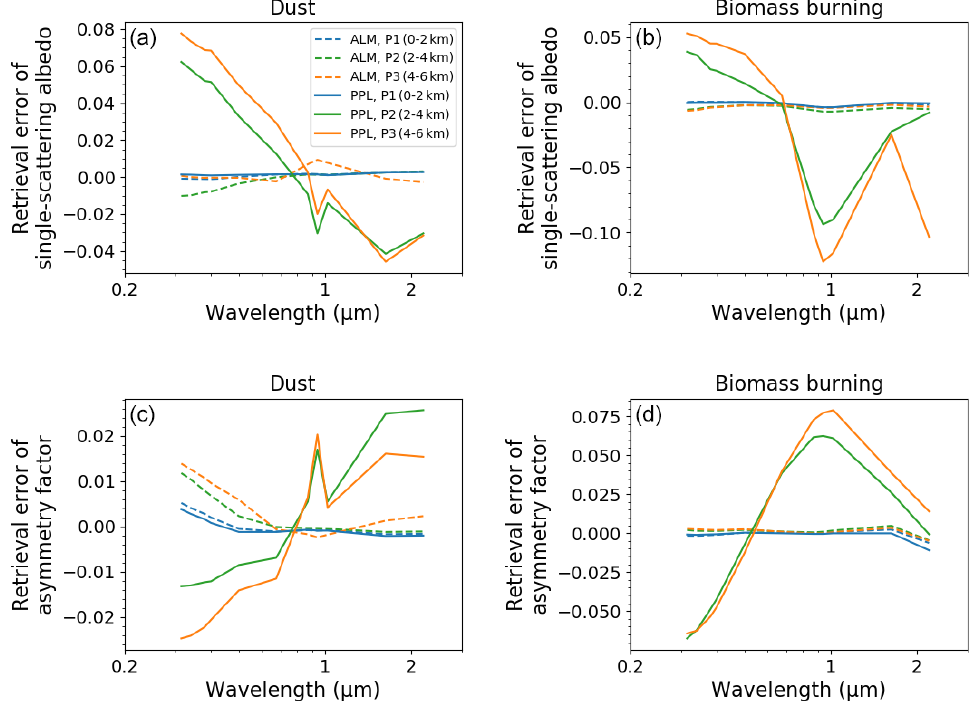
Figure 3. Retrieval error of the single-scattering albedo (a, b) and asymmetry factor (c, d) from the simulation data for the dust (a, c) and biomass burning models (b, d) with different aerosol vertical profiles of 0 to 2km (blue), 2 to 4km (green), and 4 to 6km (orange). The solid and dashed lines are the retrieval errors for the simulations data in the almucantar (ALM) and principal plane (PPL) geometries, respectively. Note that the y -axis ranges for dust and biomass burning differ in the plots.